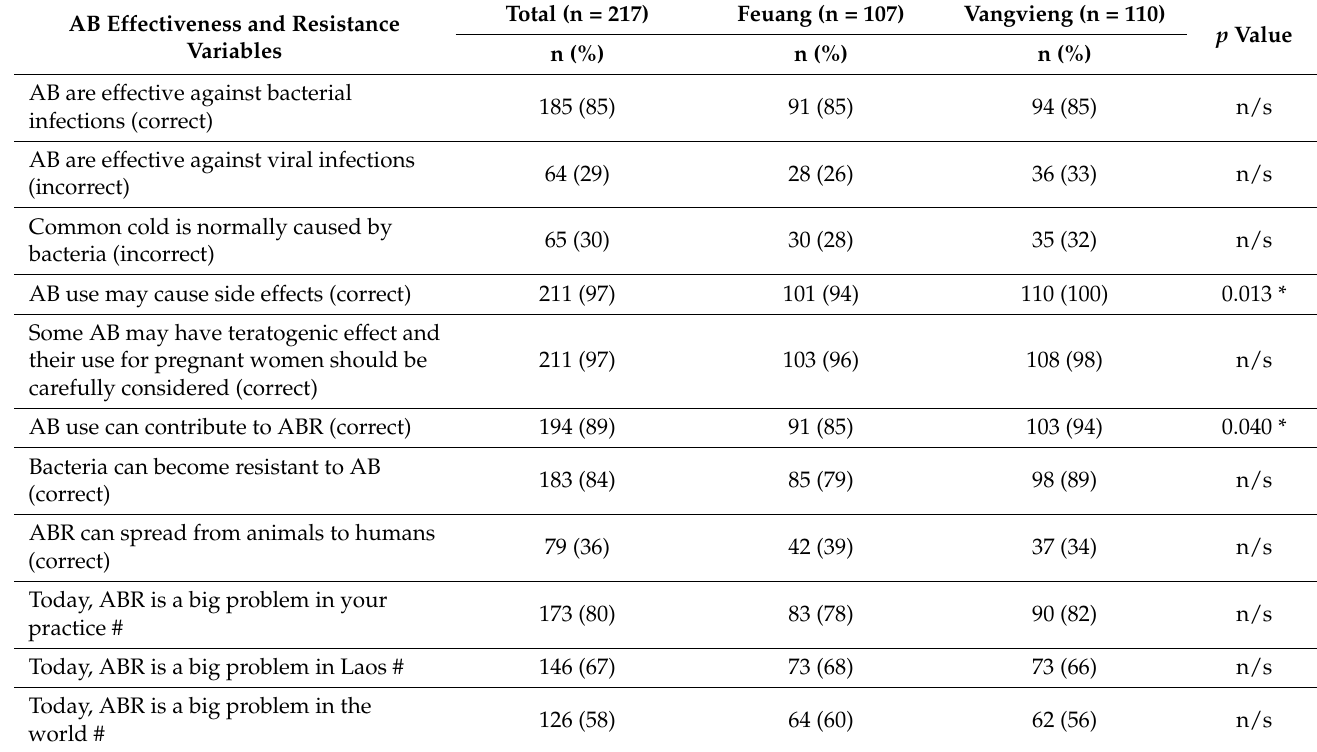
Table 2. Knowledge of participants regarding antibiotic effectiveness and resistance.